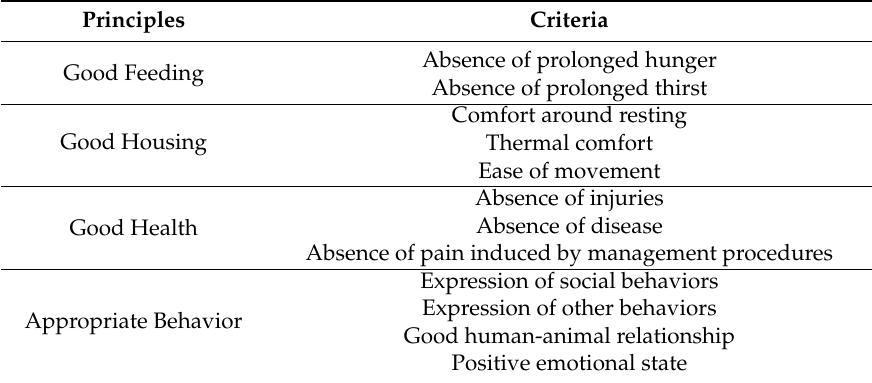
Table 1. Welfare Quality ® principles and criteria (adapted from Welfare Quality ®